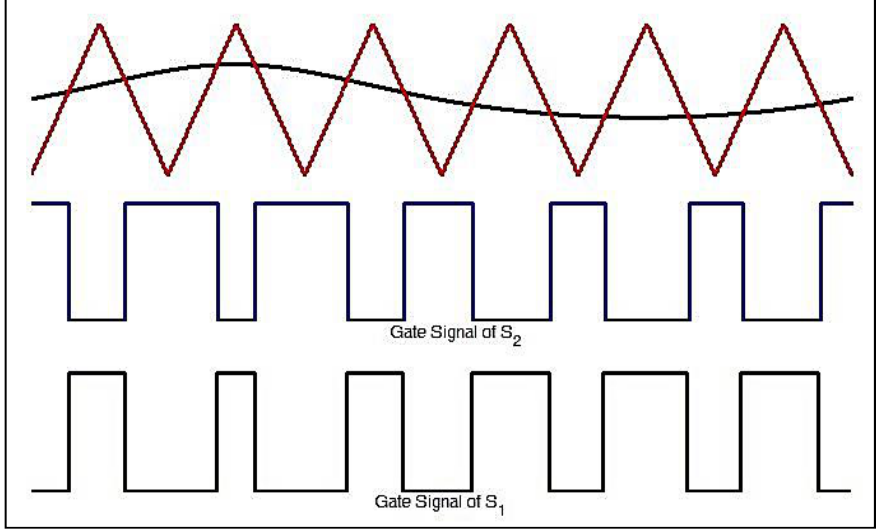
Figure 10. Modulation principle of semi-Z-source